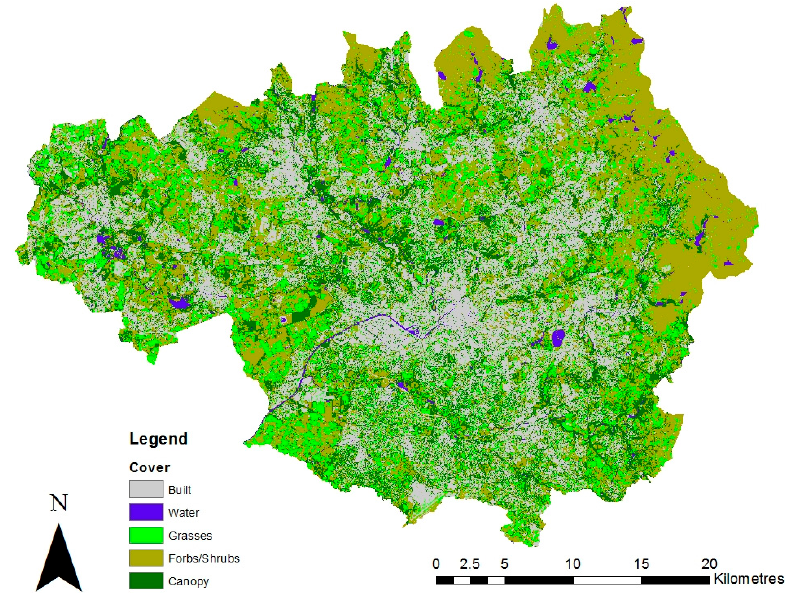
Figure 4. Result of the initial classification (Overall Accuracy 85%; Cohen’s Kappa 0.86). Contains City of Trees (2011), Ordnance Survey (2017) and European Space Agency (2016)